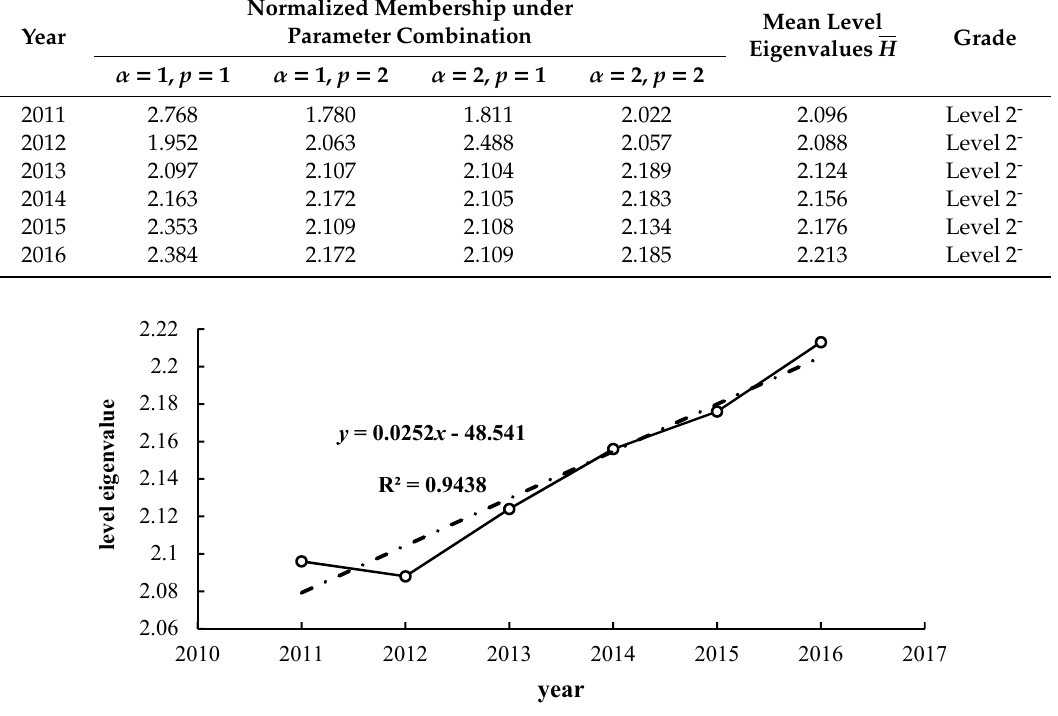
Figure 9. Trend graph of mean of level eigenvalues over time.